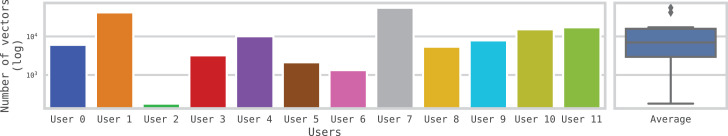
Number of vectors per user